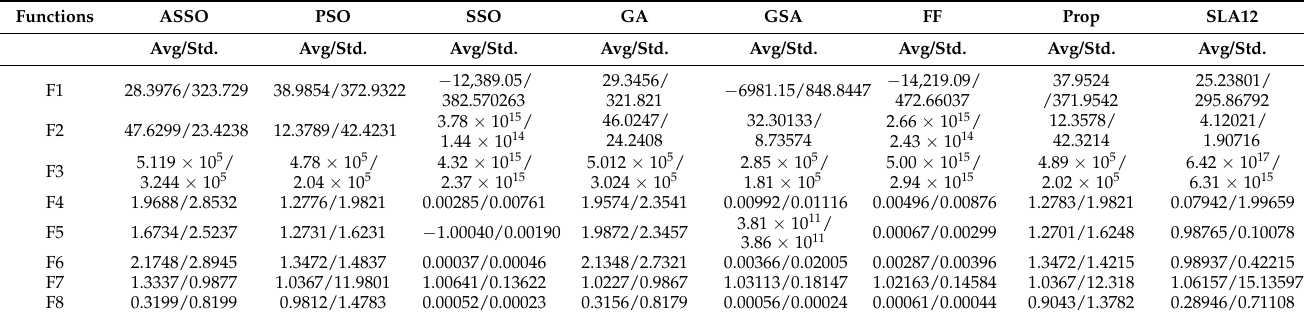
Table 8. Comparison of different optimization techniques in feature